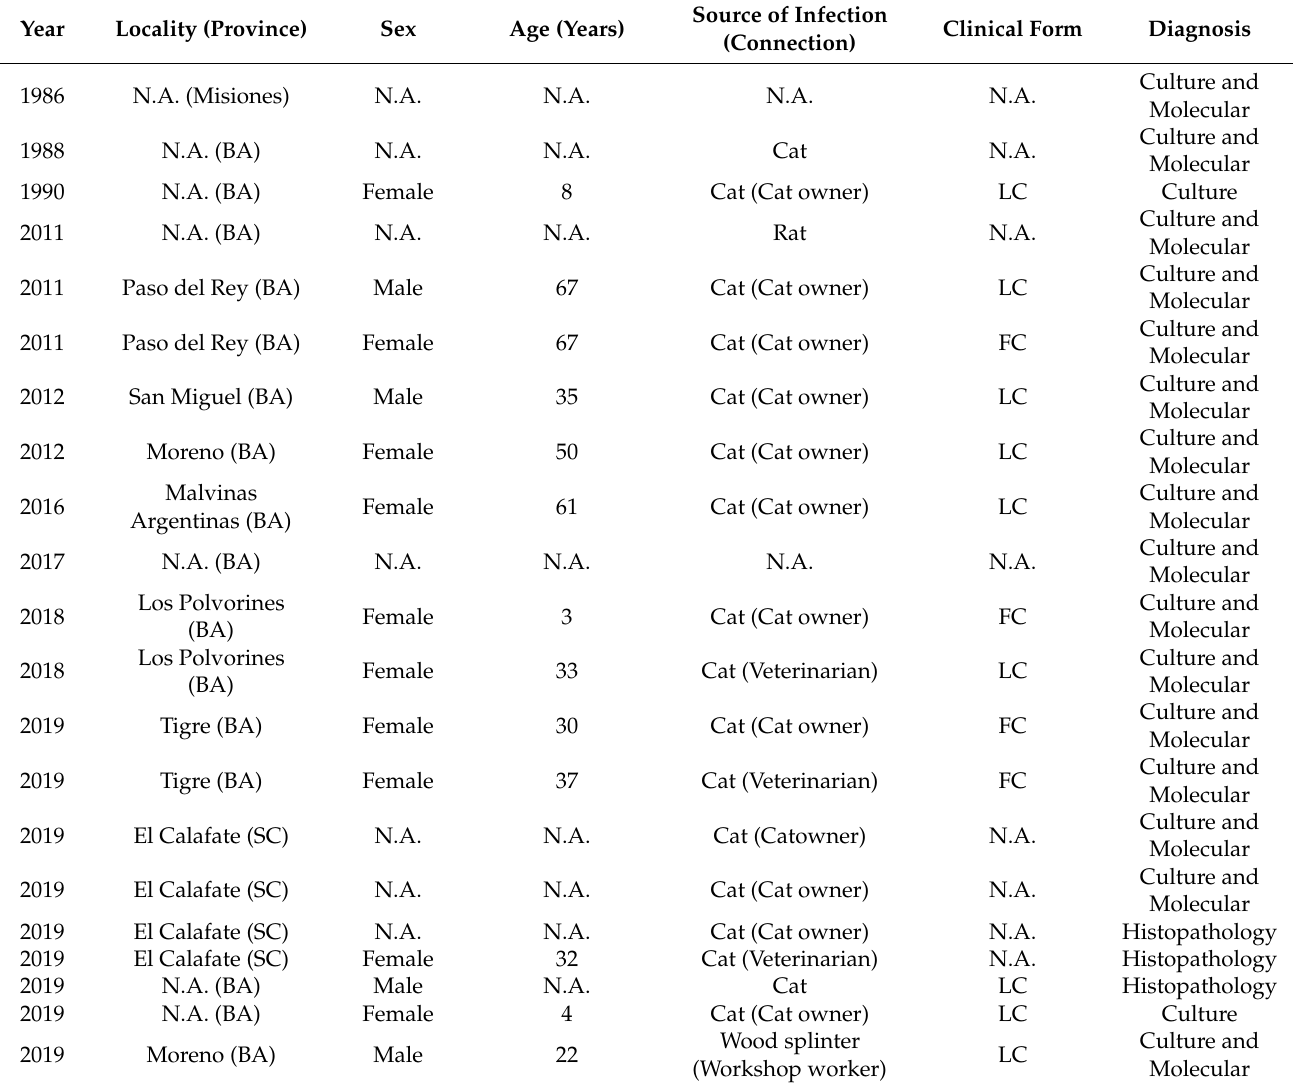
epidemiological nexus were human cases with sporotrichosis caused by S. brasiliensis who were bitten or scratched by these sick animals. Cutaneous lesions in cats were comparable with those previously described in different cat populations from Brazil [41], including crust, ulceration and presence of pus and blood, as well as respiratory signs and weight loss, with sneezing being the most frequent. Most cutaneous lesions were localized on the head, especially the nose and ears, and in a few cases on limbs and tail (Figure 4). Table 1. Human cases of sporothrichosis caused by S. brasiliensis in